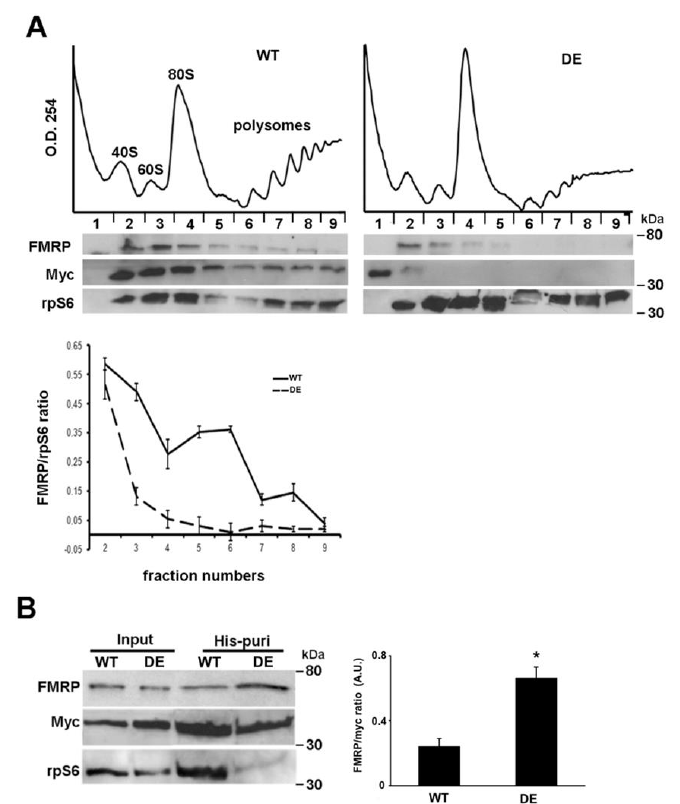
Figure 4. Ribosomal RACK1 recruits FMRP on translational machinery. RACK1 recruits FMRP on polyribosomes. ( A ), Amount of FMRP and rps6, examined by immunoblotting, on ribosomal fractions collected by polysome profiling conducted on SH-SY5Y cells overexpressing Myc-RACK1WT (WT) or Myc-RACK1DE (DE) proteins. ( Lower ) The graphic quantifies the amount of FMRP normalized to the level of rpS6 on ribosome and polyribosome fractions (from 2 to 8 fractions) measured by densitometry on bands related to immunoblottings of three independent experiments. All bar graphs represent the mean and S.D. ( B ) ( Left ) immunoblotting for FMRP, rpS6 and Myc antibodies on proteins eluted by histidine purification from SH-SY5Y cells overexpressing Myc-RACK1WT (WT) and Myc-RACK1DE (DE) proteins. The amount of FMRP purified from eluted imidazole RDE was more elevated than that purified with RWT, while the level of rpS6 was reduced in purified RDE. ( Right ), quantification of FMRP co-purified with WT or DE measured by densitometry on bands related to immunoblottings of three independent experiments. All bar graphs represent the mean and S.D. of FMRP level normalized to the amount of purified Myc-fusion proteins. Student’s T-test was used to calculate p values * < 0,01.